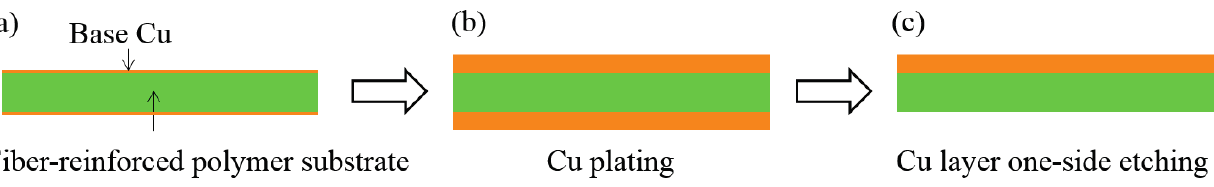
Figure 3. Bilayer specimen producing process: ( a ) fiber-reinforced polymer substrate with two base Cu with thickness of 1 μ m; ( b ) electrochemical Cu plating with thickness of 5~20 μ m symmetrically on the base Cu; and ( c ) one side Cu etch